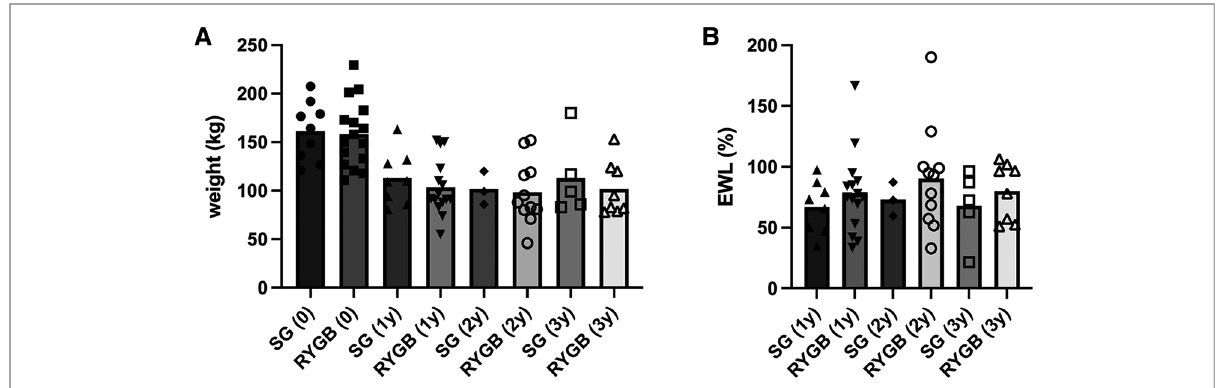
FIGURE 2 Development of weight and excess weight loss (EWL) of patients undergoing bariatric surgery suffering from liver cirrhosis, strati fi ed by bariatric procedure. Weight (kg) at time of surgery (0), 1 year (1y), 2 years (2y), and 3 years (3y) after surgery ( A ). Excess weight loss [EWL (%)] after 1, 2, and 3 years ( B ). One patient was excluded due to another procedure type (Omega-Loop), impossible to fi t into the comparison. SG, sleeve gastrectomy; RYGB, Roux-en-Y-gastric